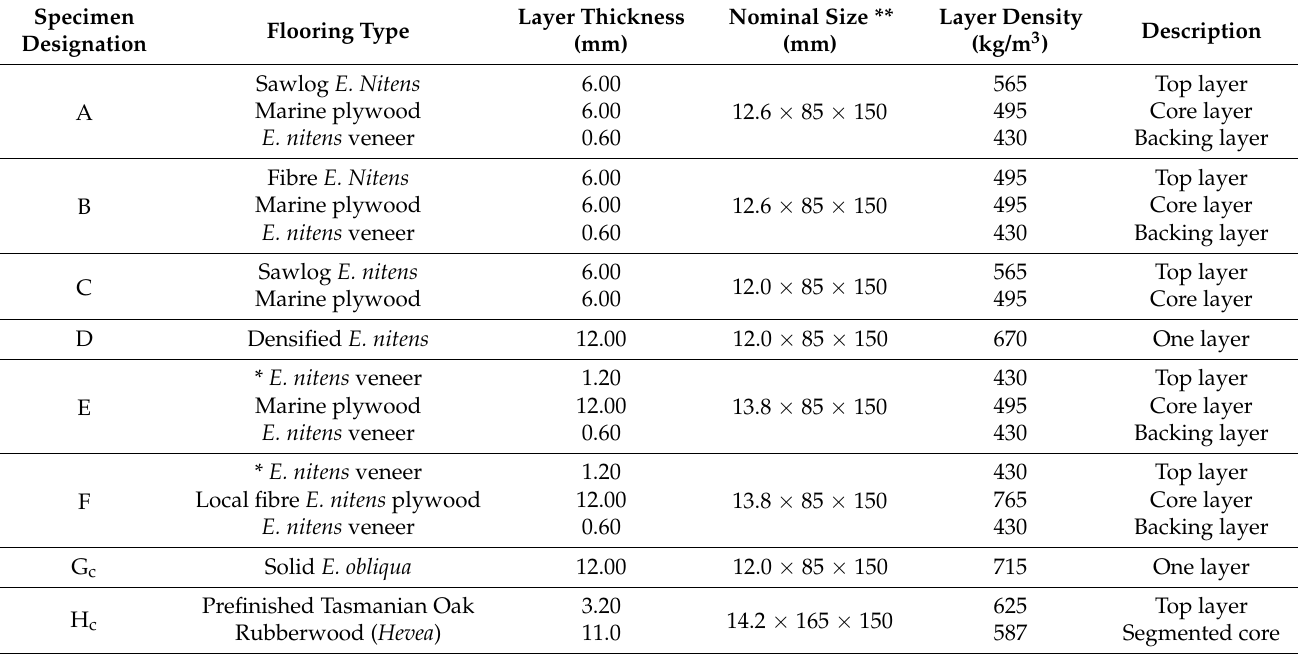
Table 1. Characteristics of the tested timber flooring